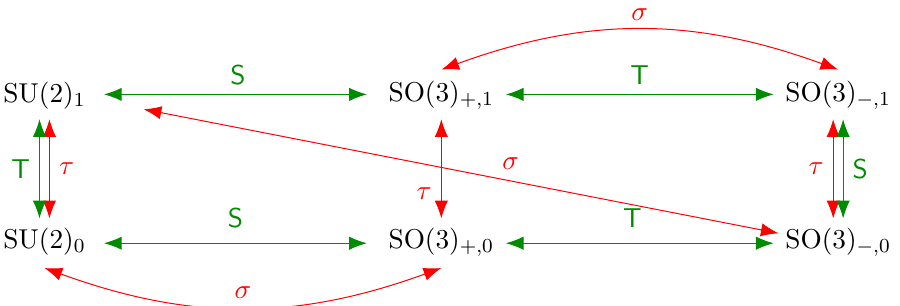
Figure 5 . Web of transformations for theories with gauge algebra su (2) . The transformations in green are the Montonen-Olive duality transformations, generating SL(2 , Z ) . The transformations in red are topological manipulations generating SL(2 , Z 2 )